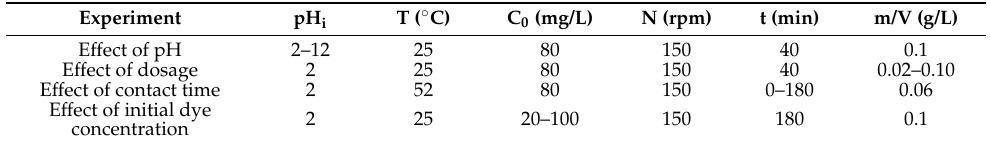
Table 1. Experimental conditions AB92 adsorption from aqueous solutions by BFO/CFO@PEG nanocomposites.